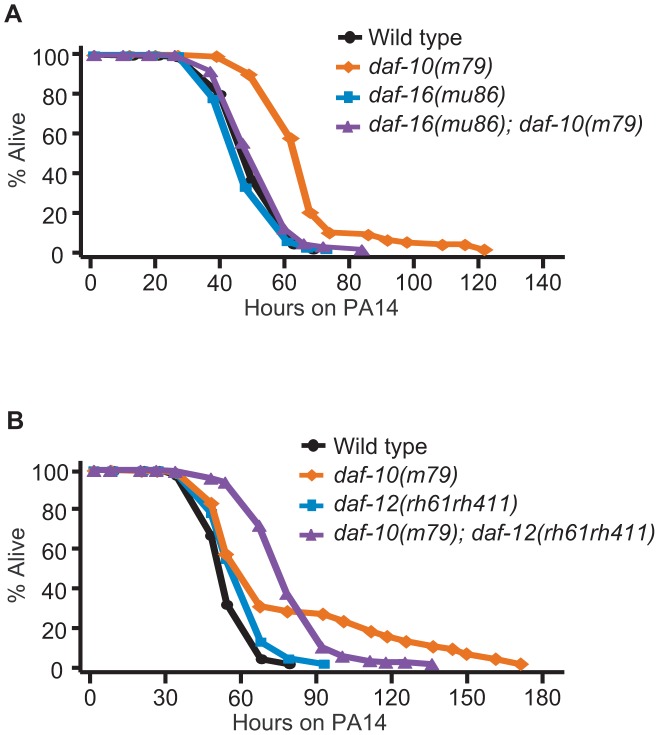
The increased PA14 resistance of daf-10 mutants requires DAF-16/FOXO.
daf-16(mu86) mutations completely suppressed the PA14 resistance caused by daf-10(m79) mutations in the big lawn assay (A), whereas daf-12(rh61rh411) mutations did not affect mean survival (B). However, daf-12 mutations altered the survival curve of daf-10(m79) mutants on PA14 in a statistically significant manner (see Figure S3 for additional repeats). A summary of the data presented in these panels and additional repeats is included in Table S2.